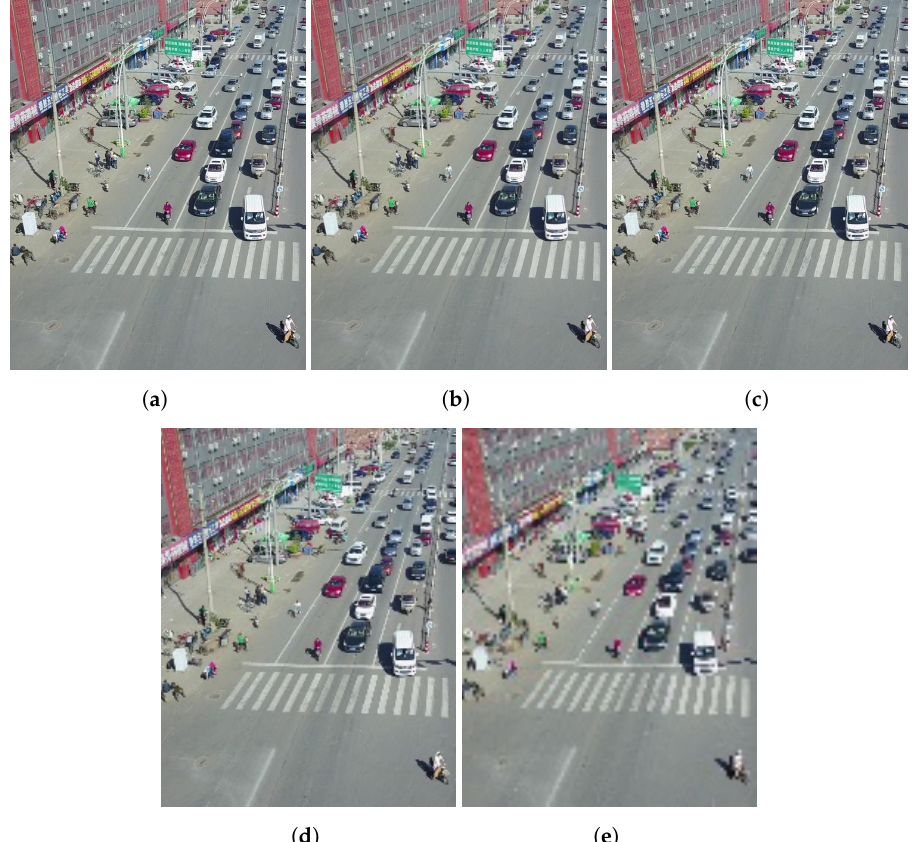
Figure A7. Example images for image resolutions with max side length. ( a ) Full res.; ( b ) Max 768 pixels; ( c ) Max 512 pixels; ( d ) Max 256 pixels; ( e ) Max 128